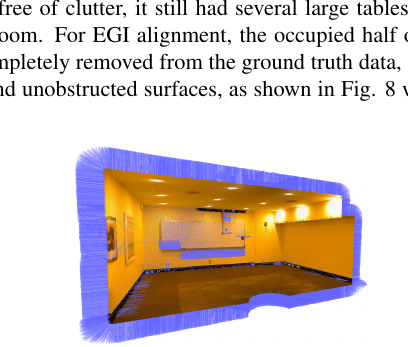
Figure 8. Cropped Trimble 2 point cloud used for EGI analysis, with normal vectors displayed as blue